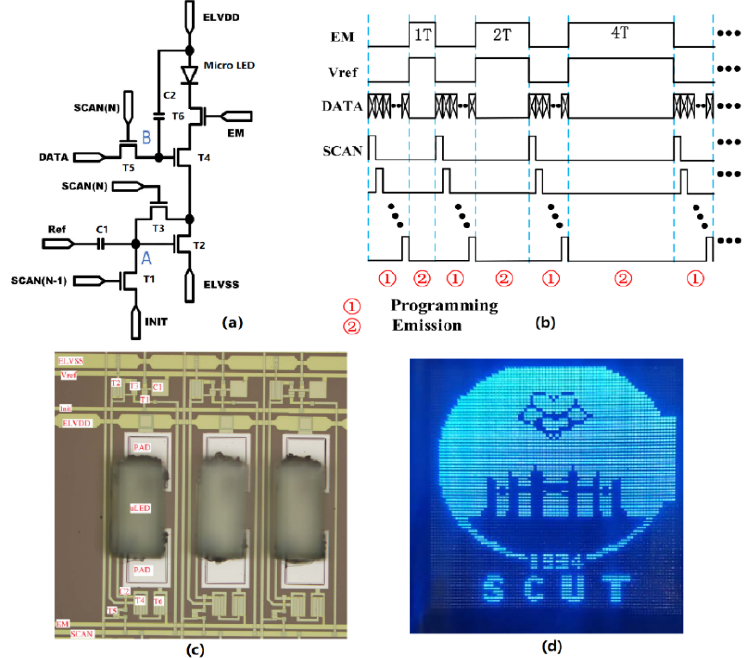
Figure 9. ( a ) Schematic of the proposed pixel circuit, ( b ) Timing diagram of the proposed pixel cir- cuit, ( c ) Optical micrograph of the Micro-LED pixel circuit, and ( d ) Display of the Micro-LED [146] (Reprinted with permission from Ref. [146]. Copyright 2022 IEEE).